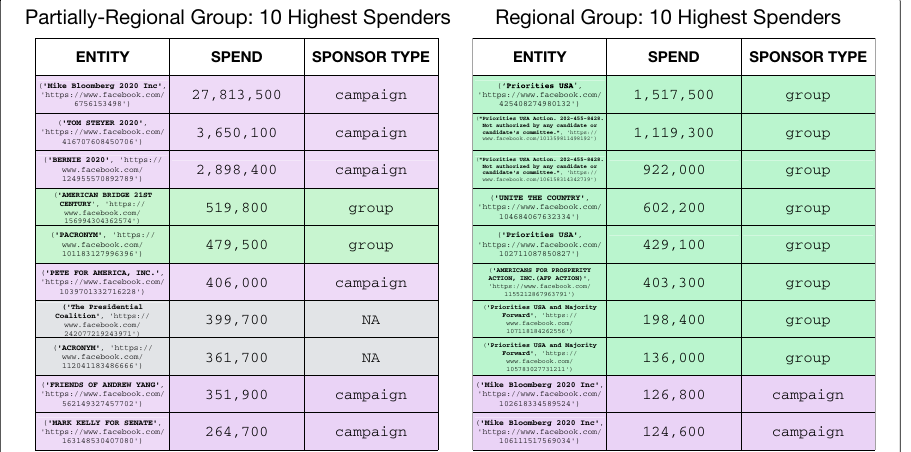
Fig. 10 The 10 highest spending funding entities in each region network (i.e., on regionally-dominated ads). Cells are colored according to sponsor type. The URL in the “entity” field is the page ID appended to “https:// www.facebook.com/”